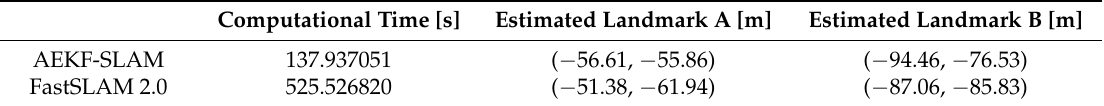
Table 4. The comparisons of the computational time and estimated the landmark A, B positions in the dense loop map derived by the AEKF-SLAM and FastSLAM 2.0.